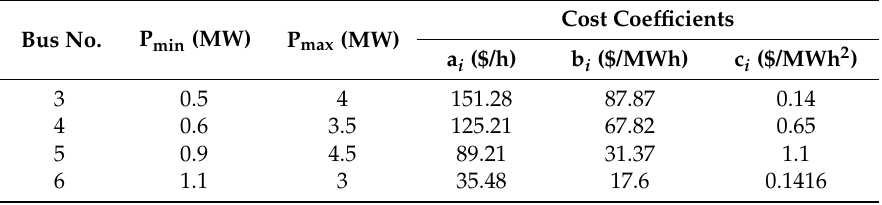
Table 1. Cost coefficients and MW limits of generators.